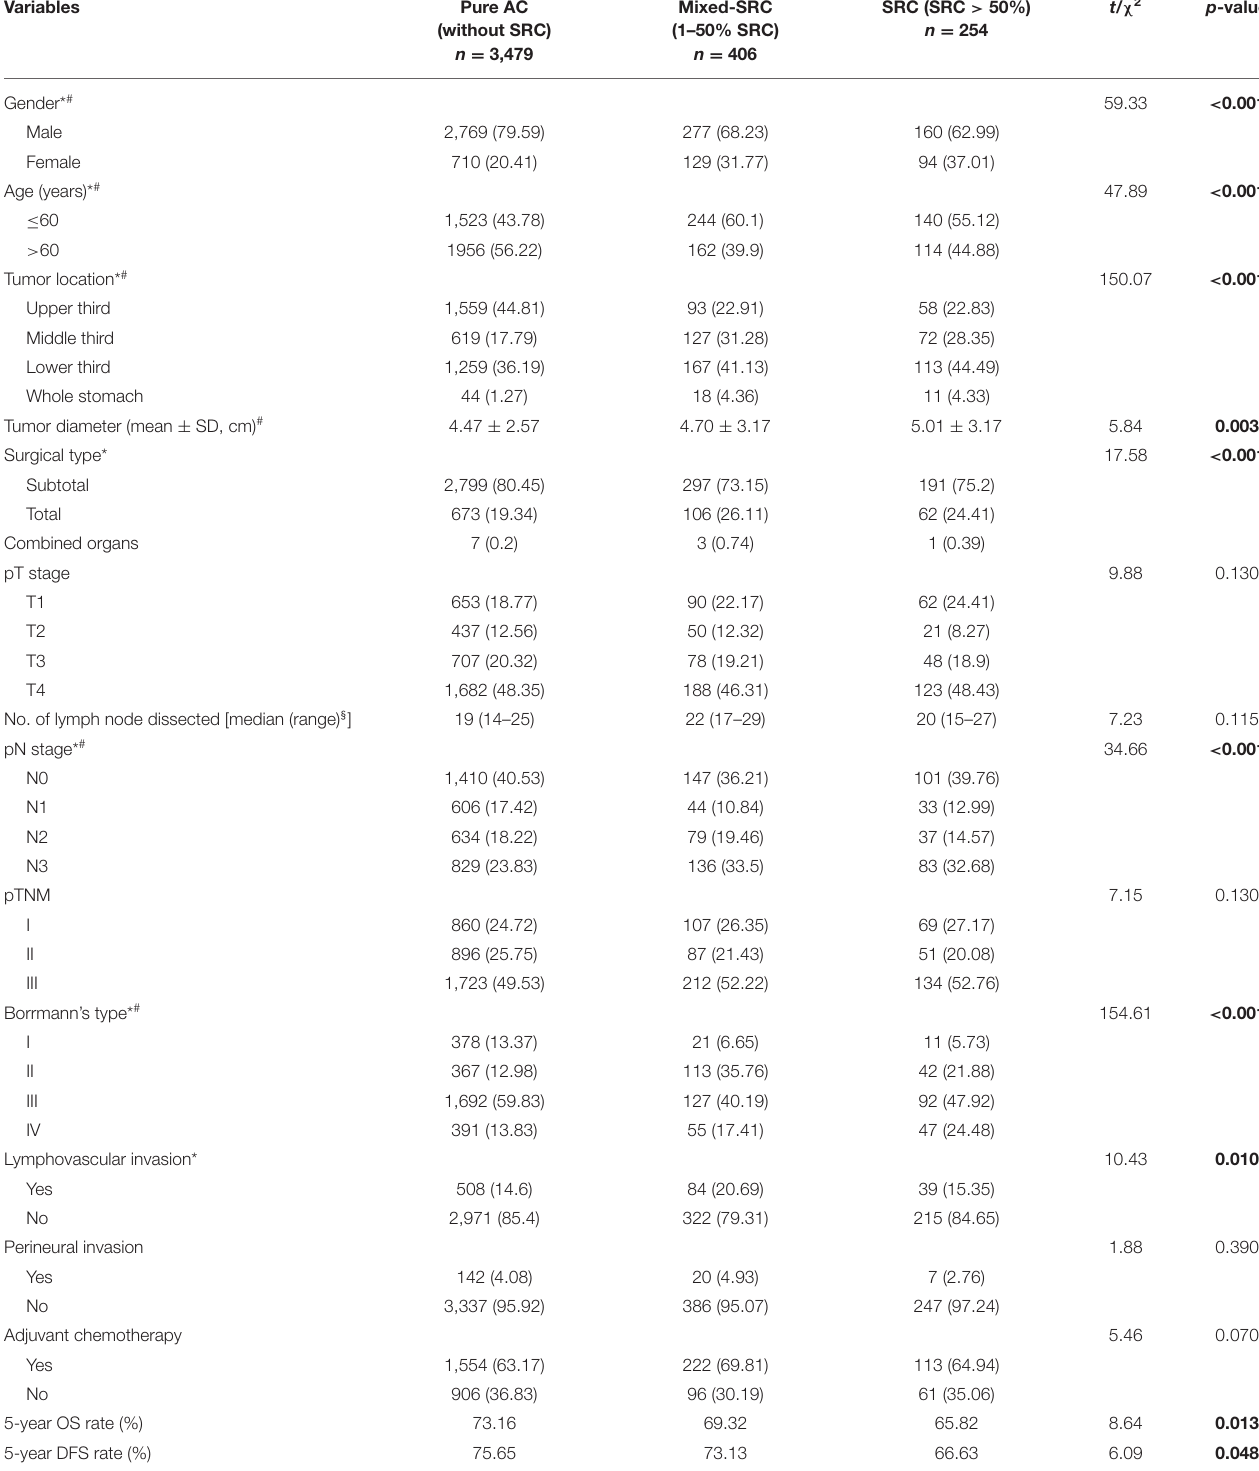
TABLE 1 | Clinicopathological characteristics of different groups according to the SRC